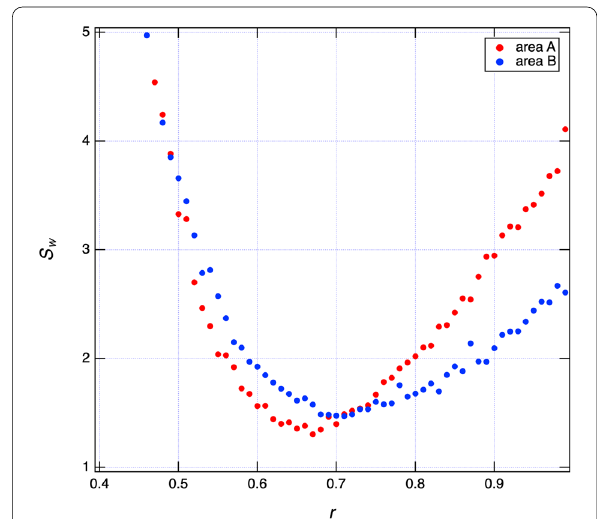
Fig. 20 Grid search results for the parameter r . Vertical axis shows S w as defined in Eq.